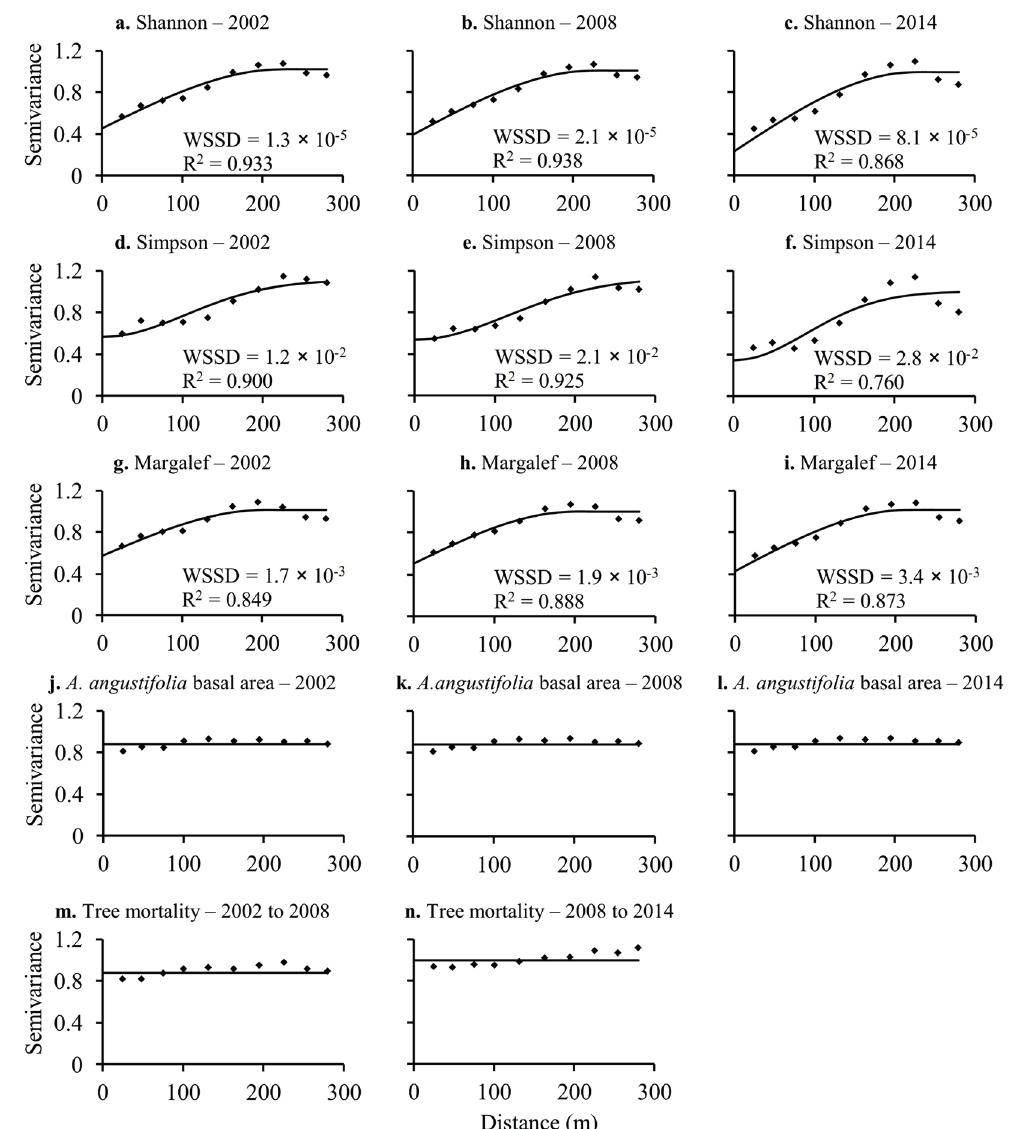
Figure 2 - Scaled semivariograms of Shannon’s index ( a to c ), Simpson’s index ( d to f ), Margalef’s index ( g to i ), and pure nugget semivariograms for Araucaria angustifolia basal area per plot ( j to l ) and annual tree mortality rates per plot ( m , n ) in a mixed tropical forest.